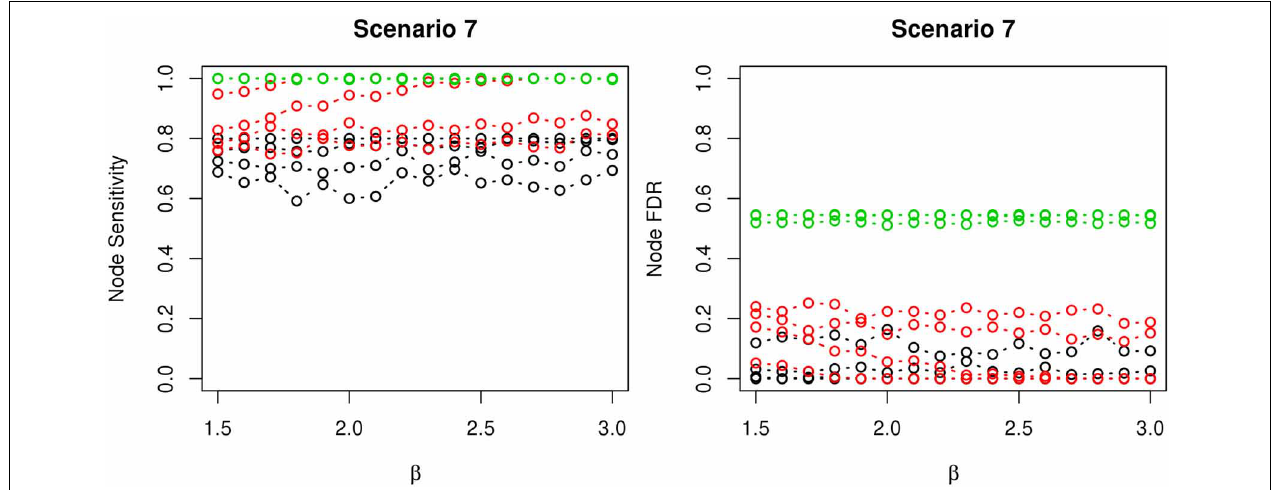
FIGURE 6 | The sensitivity and FDR of node comparisons in simulation scenario 7. The same legend is used as in Figure 3 . nPARS shows lowest node FDR